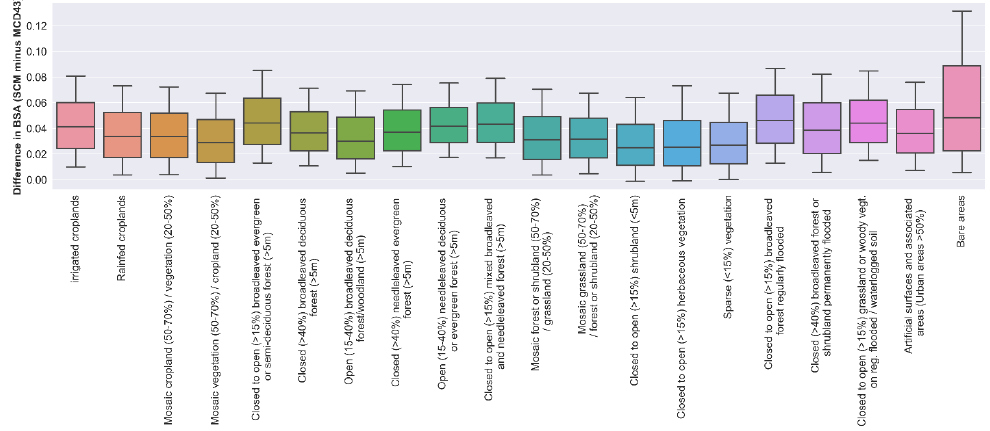
Figure 7. The distribution of differences in retrieved BSA (SCM minus MCD43) as a function of GlobCover land use classes between DOY 180 and 350 of the year 2010. The boxplots’ center line shows the mean difference, the box shows the quartiles (25% and 75%), whereas the whiskers show the 10% and 90% range. The outliers beyond these limits are not shown. The box colors indicate different categories of land cover.